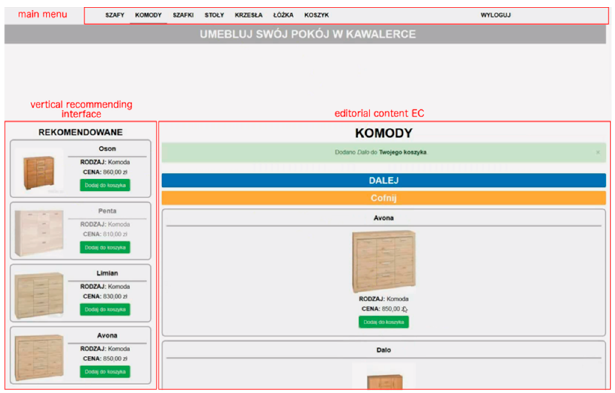
Figure 4. Vertical layout of the recommending interface.